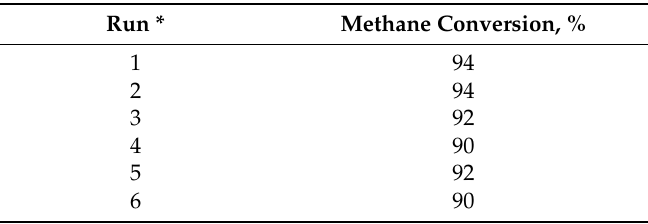
Table 3. Methane conversion in six catalytic